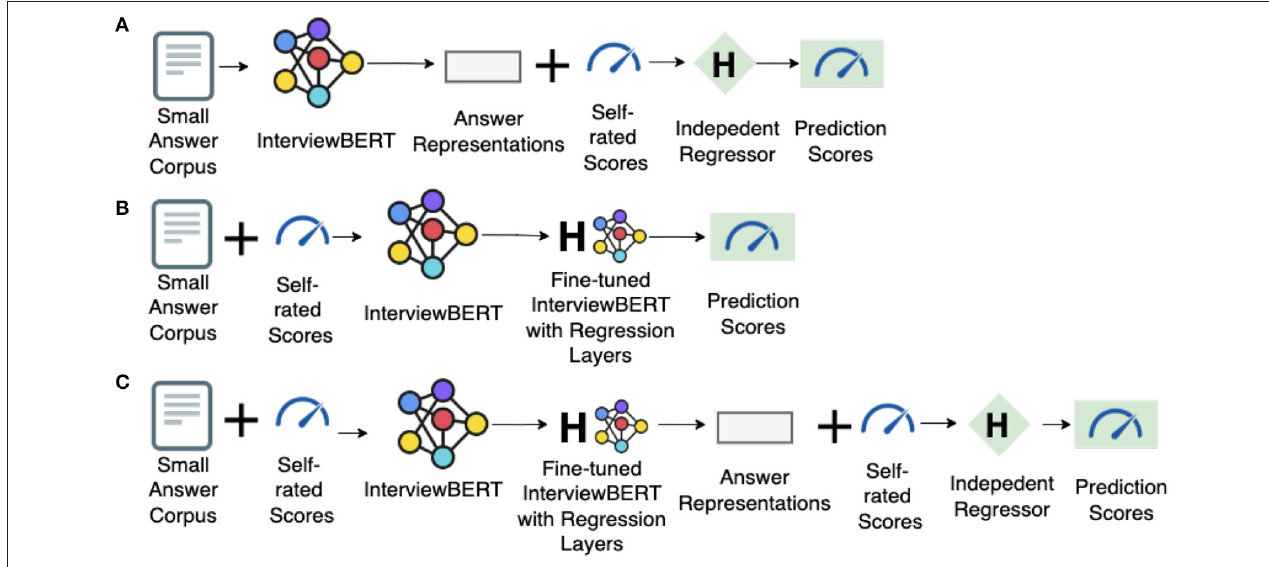
FIGURE 3 | Illustration of different ways of using InterviewBERT. (A) Train an independent regressor without fine-tuning. (B) Fine-tune InterviewBERT. (C) Hybrid